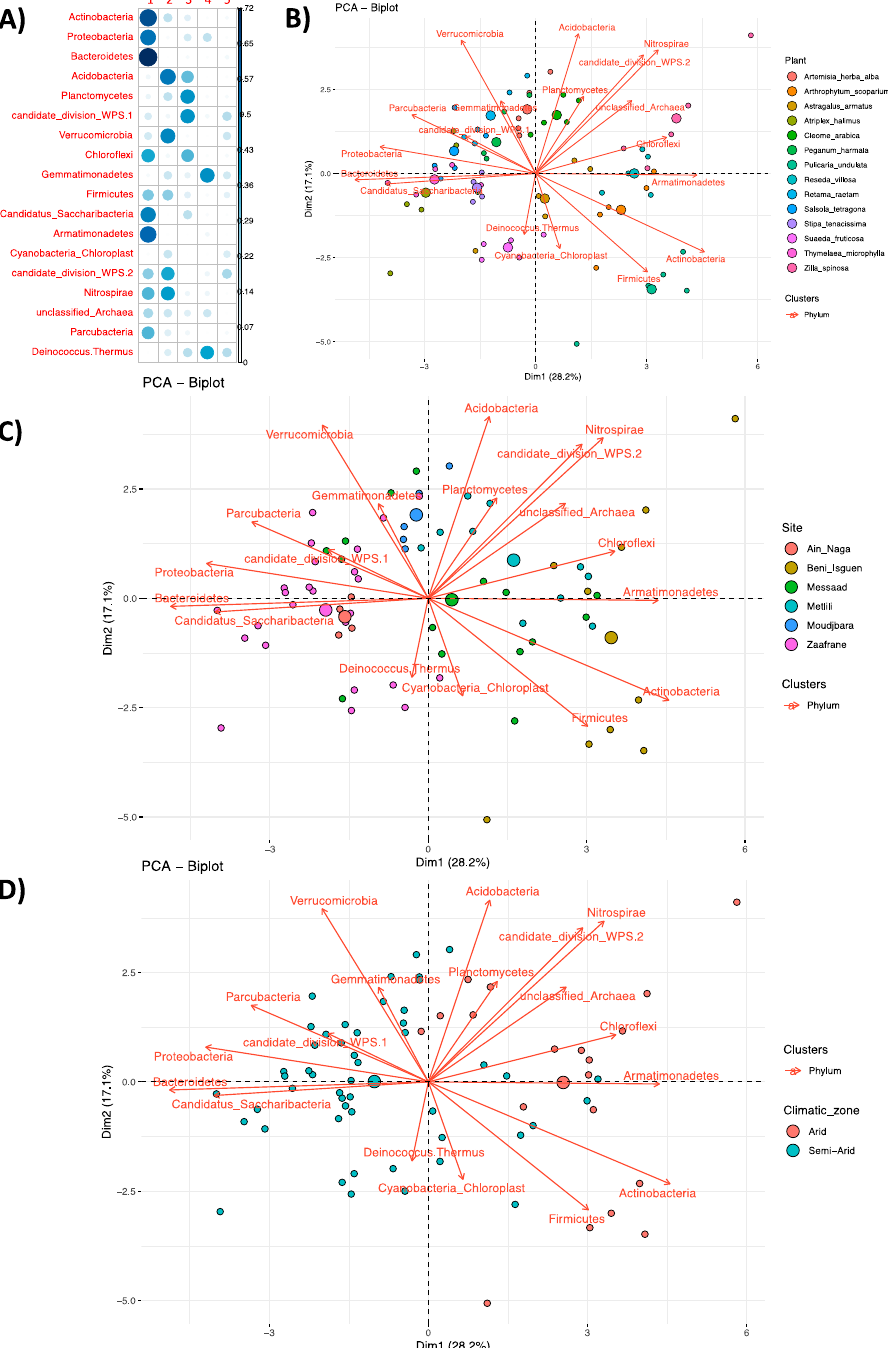
Figure 5. PCA. ( A ) Cos2 contribution of different phyla on PCA dimensions (1, 2, 3, 4, 5). PCA graphs according to plant, sampling site and climatic zone factors. ( B ) PCA-Biplot at phylum level according to plant species; ( C ) PCA-Biplot at phylum level according to sampling site; ( D ) PCA-Biplot at phylum level according to climatic zone. Each bigger dot represents the mean value for each considered parameter while each little dot represents each considered